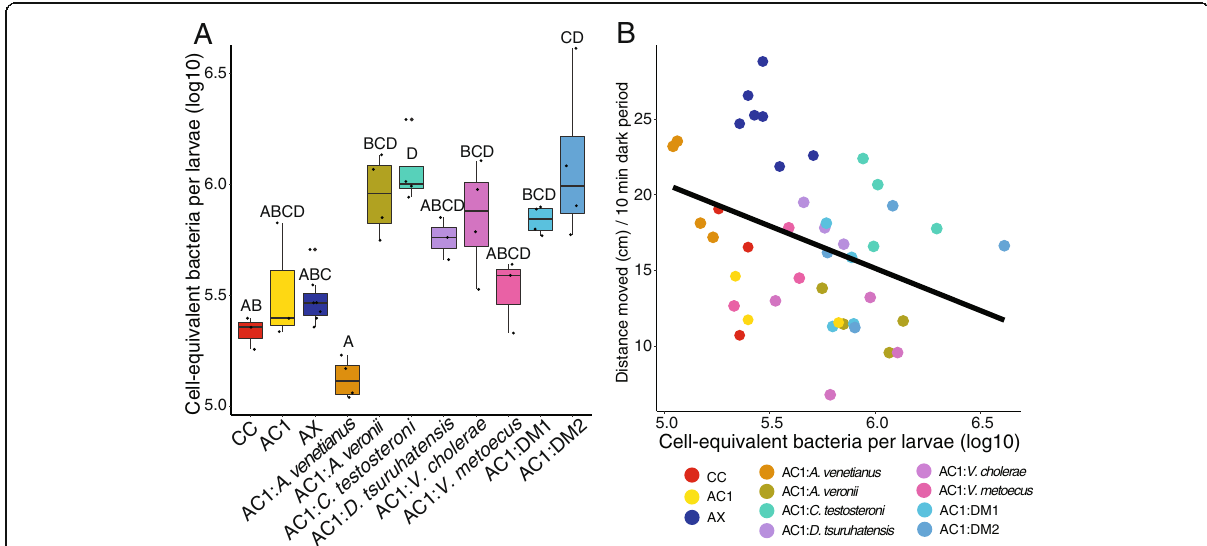
Fig. 4 Results of 16S rRNA gene droplet digital PCR. Analysis revealed group differences in bacterial load per larvae ( a ). These differences correlate with behavior ( b ; p = 0.017, R 2 = 0.11); CC = conventionally colonized; AC1 = axenic colonized on day 1; AX = axenic; AC1:DM1= A. venetianus + V. metoecus + C. testosteroni + D. tsuruhatensis + A. veronii ; AC1:DM2 = A. venetianus + C. testosteroni + D. tsuruhatensis + A. veronii